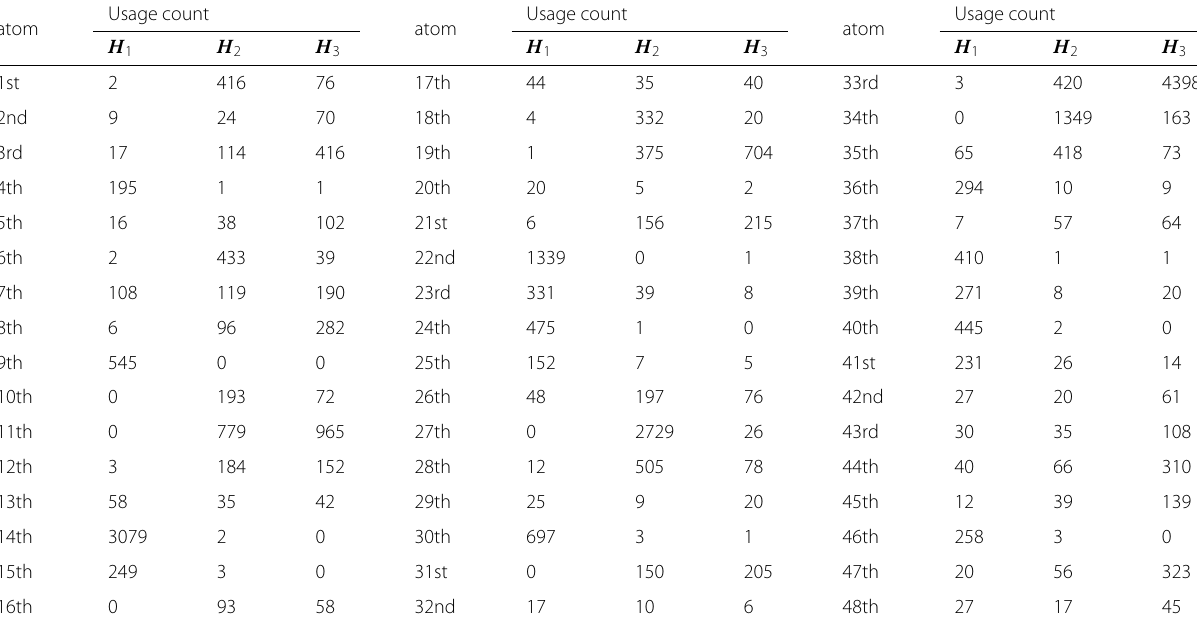
Table 1 Summary on how many times that a specific atom is invoked by different cluster of features